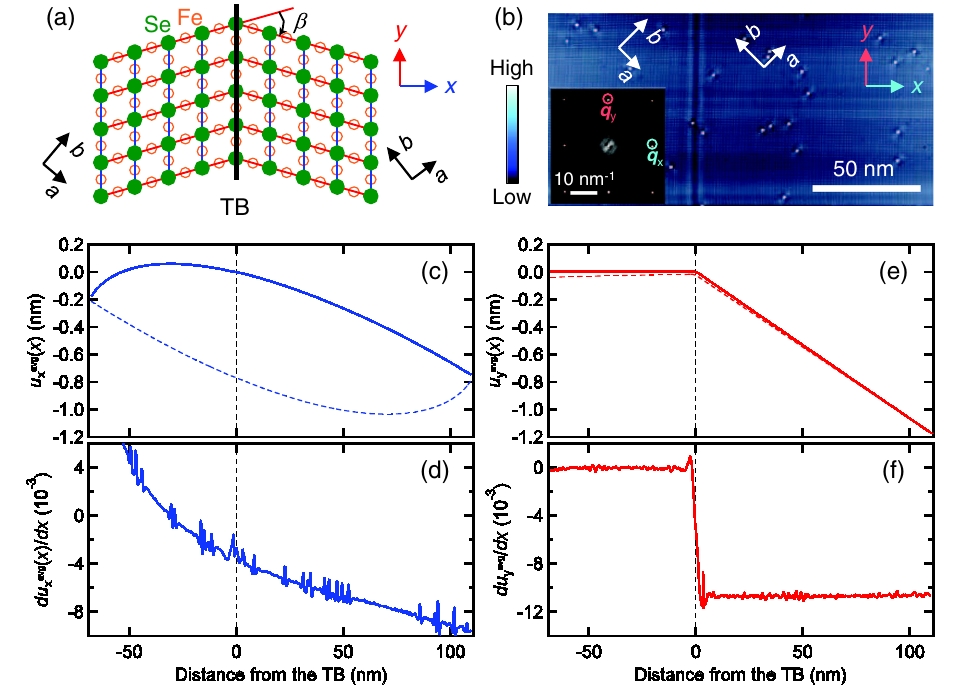
FIG. 6. (a) Schematic top view of the atomic arrangement near the TB of FeSe (not in scale). Note that an atomic periodicity along the x direction is hardly affected by the TB. (b) A constant-current STM image taken over a field of view of 180 × 90 nm 2 on a grid of 4096 × 2048 pixels. The setup conditions for imaging are V 95 mV and I 100 pA. Inset: Fourier-transformed STM image s ¼ þ t ¼ taken in the left domain of the main panel. A peak at q is sharp and well isolated from other features, guaranteeing that q · u ð r Þ can be x x treated as a spatially varying phase of the q modulations. (The same is true for q .) (c) The x component of u ð r Þ averaged over the y axis. x y Thick solid line and thin dashed line denote the data taken by the forward (left to right) and backward (right to left) scans, respectively. The symmetric hysteretic behavior between the forward and backward scans indicates that u avg x ð x Þ is governed by the creep of the scanner. No anomaly is observed at the TB. (d) The x derivative of u avg x ð x Þ . Spikelike features are associated with the point defects in the image. (e) The y component of u ð r Þ averaged over the y axis. Thick solid line and thin dashed line denote the data taken by the forward (left to right) and backward (right to left) scans, respectively. Since the y direction is the slow-scan direction, the effect of the creep is small. A clear kink is observed at the TB. (f) The x derivative of u avg y ð x Þ